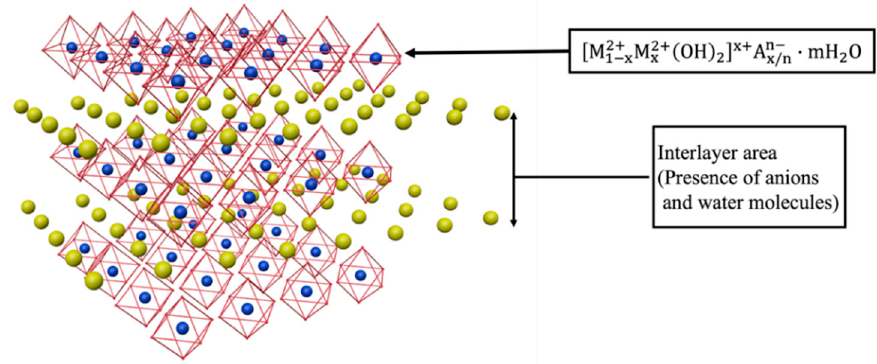
Nanomaterials 2022 , 12 , x